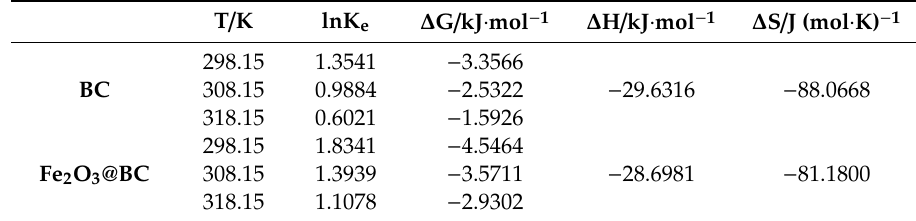
Table 7. Thermodynamic parameters of BPA adsorption onto BC and MBC at various temperatures. T /